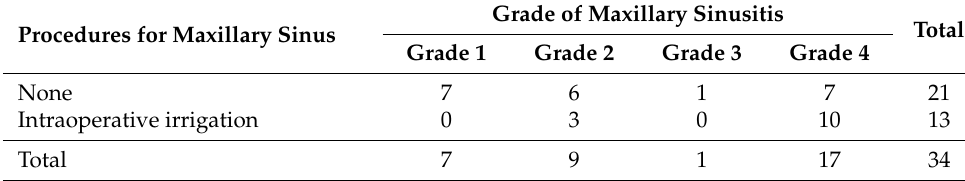
Figure 3. Irrigation of maxillary sinus during surgery. Table 2. Procedures for maxillary